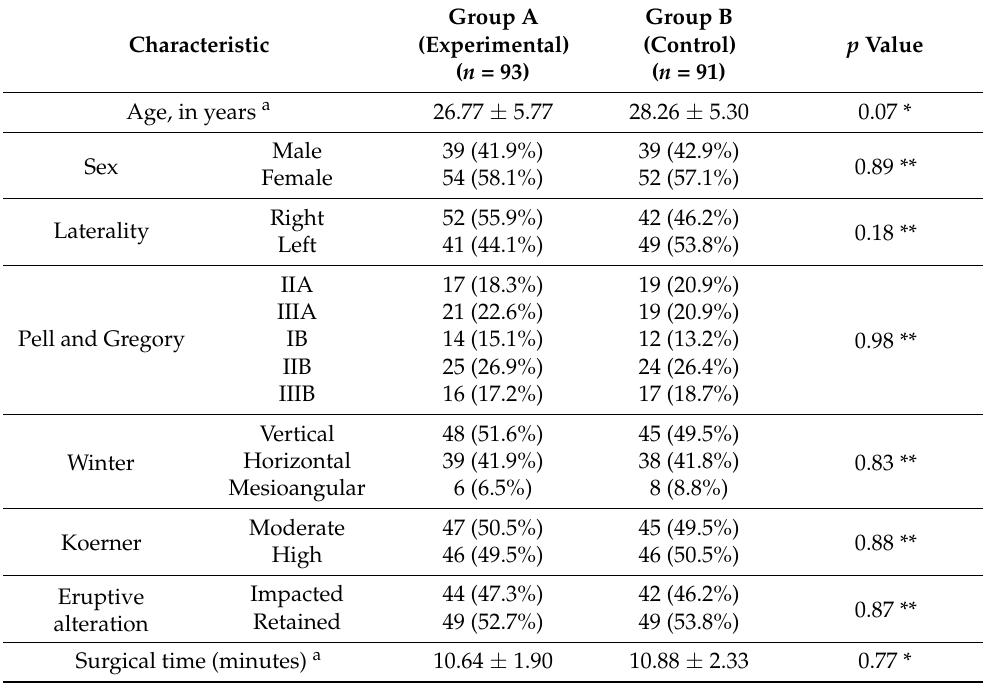
Table 1. Comparison of sociodemographic data and characteristics of the third molar between the two groups, A (experimental) and B